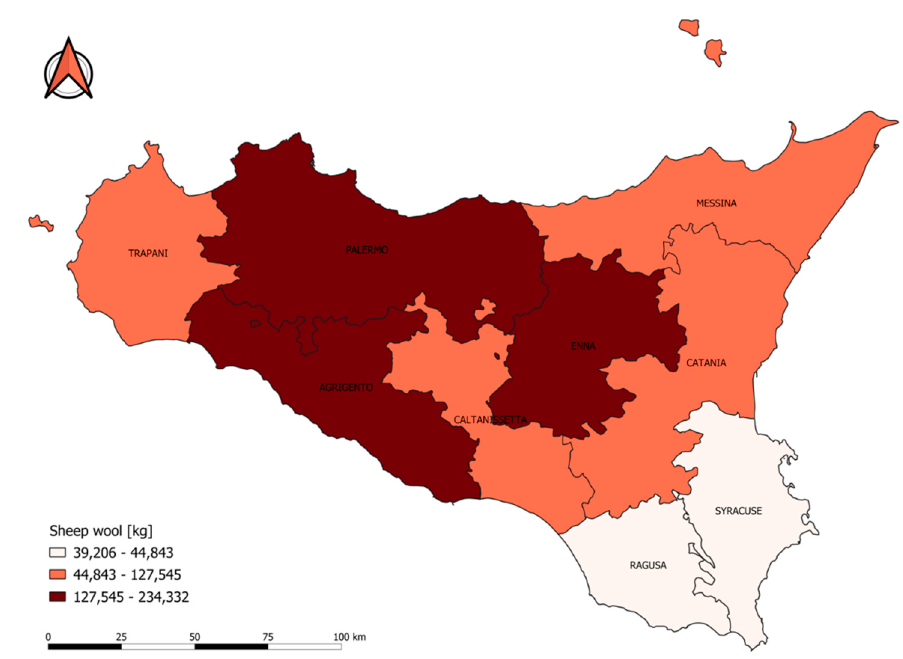
Figure 5. Distribution of the yearly sheared sheep wool within the study area (Sicily) at a provincial level.